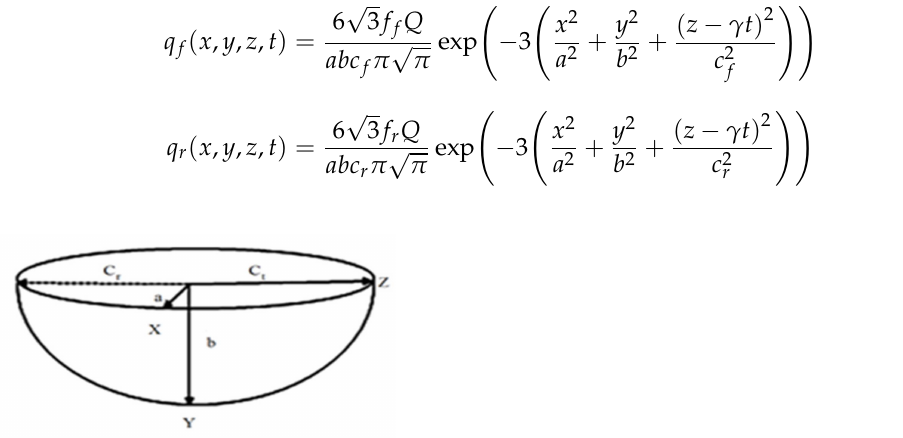
Figure 5. Volumetric weld flux.